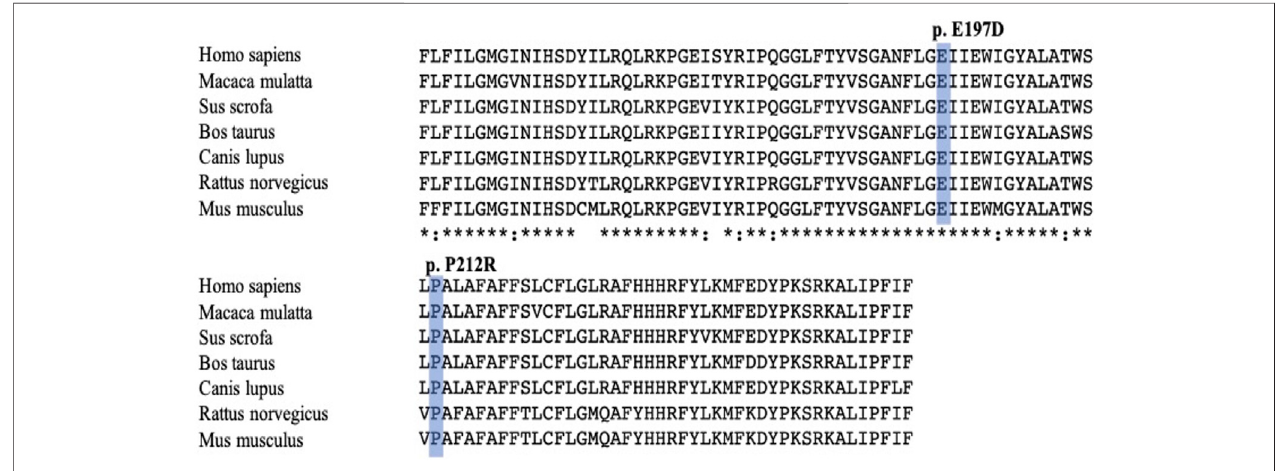
FIGURE 4 | Comparison between multiple sequence alignment of human steriod 5 α -reductase type 2 and other sequence proteins vertebrate reductases. Mutations reported in this study are shaded blue. Alignment was performed with ClustalW program (http://clustalw.genome.jp/).